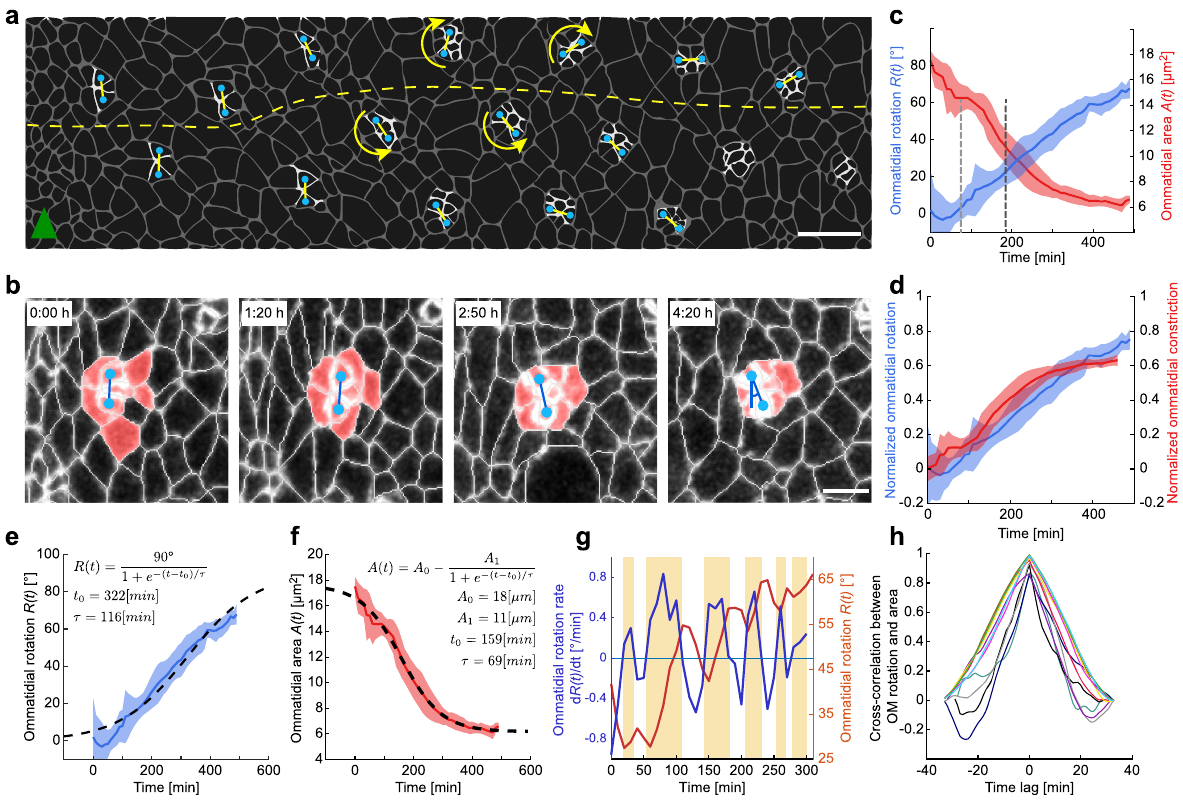
Fig. 1 Dynamics of ommatidial cluster rotation reveal a pulsatile, continuous process. a Representation of ommatidial clusters posterior to the morphogenetic furrow (MF, indicated by green arrowhead) in the region of the equator (yellow dashed line); blue dots denote centroids of photoreceptors R2 and R5, highlighting the angle of clusters relative to the MF and thus rotation of clusters from their initial position as they mature (away from the MF) (Supplementary Fig. 1a – c for more details). b Snapshots at the indicated timepoints from a movie of E-cad::GFP depicting ommatidial pre-cluster maturation and rotation. Image segmentation is shown in the white overlay. See Supplementary Fig. 1 for more details. Centroids of R2 and R5 cells were used to measure the degree of rotation over time as shown in the right panel. Cells highlighted in red are the eight photoreceptors of the cluster. c Rotation (blue) and apical surface area (red) of ommatidial clusters as a function of time. Measurements from different ommatidia were temporally aligned with the time when R7-cell joined the cluster (highlighted in this and subsequent graphs by dark gray dashed line, light gray dashed line highlights time point when R1/R6 join the cluster). Line shows mean, and shaded region indicates standard deviation. d Normalized ommatidial rotation ( Rt(90) , blue) and normalized apical surface constriction ( 1 − A(t)/A 0 , red) of individual clusters are shown as a function of time. Line shows mean, and shaded region indicates standard deviation. Note the close association between rotation and constriction. e Sigmoid fi t (dashed line) to ommatidial rotation, R ( t ) (line shows mean, and shaded region indicates standard deviation). The angular velocity during rotation is calculated from the fi t parameters as Ω ¼ 60 ´ 90 = 4 τ (cid:2) 11 (cid:3) = h f Sigmoid fi t (dashed line) to the ommatidial area, A ( t ) (line shows mean, and shaded region indicates standard deviation). The rate of ommatidial constriction is calculated from the fi t parameters as C ¼ 60 ´ A 1 = 4 τ (cid:2) 2 : 5 ½ μ m 2 = h (cid:4) . g Change in degree of rotation over time of an individual cluster showing d R ð t Þ = d t , in blue (left axis), and R ( t ), orange (right axis). Pulsatile behavior is marked by orange shaded boxes denoting periods, or pulses, of positive rotation with anti-rotation behavior in between such periods (white areas). h Cross-correlation between standardized ommatidial rotation and constriction as a function of time lag for individual ommatidia, denoted by different colored lines. Note that the maximum cross-correlation for all ommatidia occurs at zero time lag, implying a simultaneous occurrence of these two processes and a close association between them. Measurements in c – f and h are averaged over 11 clusters from two pupae in >300min movies. OM; ommatidia. All scale bars: 3 µ